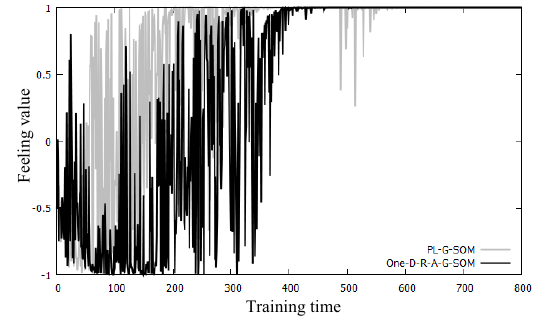
Fig. 11. Comparison of success rates between the conventional PL-G-SOM and proposed One-D-R-A-G-SOM.